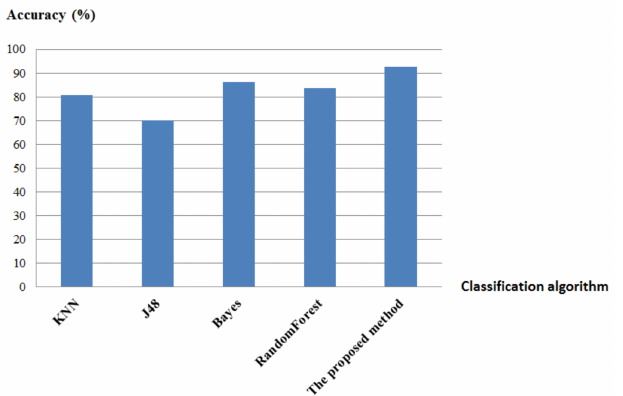
Figure 6. Comparison of accuracy between the proposed method and four traditional classification